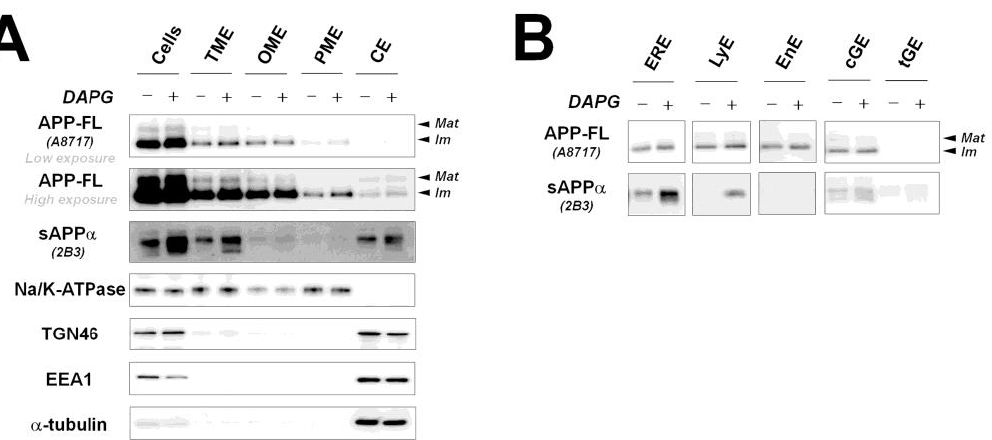
Figure 4. Examination of APP-FL and sAPPα levels in intracellular organelles after DAPG treatment. ( A ) Changes of APP-FL and sAPPα levels induced by DAPG in total cell lysate (Cells, 8 μg), total membrane-enriched (TME, 4 μg), organelle membrane-enriched (OME, 2 μg), plasma membrane-enriched (PME, 2 μg), and cytosol-enriched (CE, 6 μg) fractions. Markers of intracellular organelles including the plasma membrane (Na/K-ATPase), trans-Golgi (TGN46), early endosome (EEA1), and cytosol (α-tubulin) were analyzed. ( B ) Changes of APP-FL and sAPPα levels induced by DAPG in the ER-enriched (ERE, 1 μg), lysosome-enriched (LyE, 1 μg), cis-Golgi-enriched (cGE, 1 μg), and trans-Golgi-enriched (tGE, 1 μg) fractions.